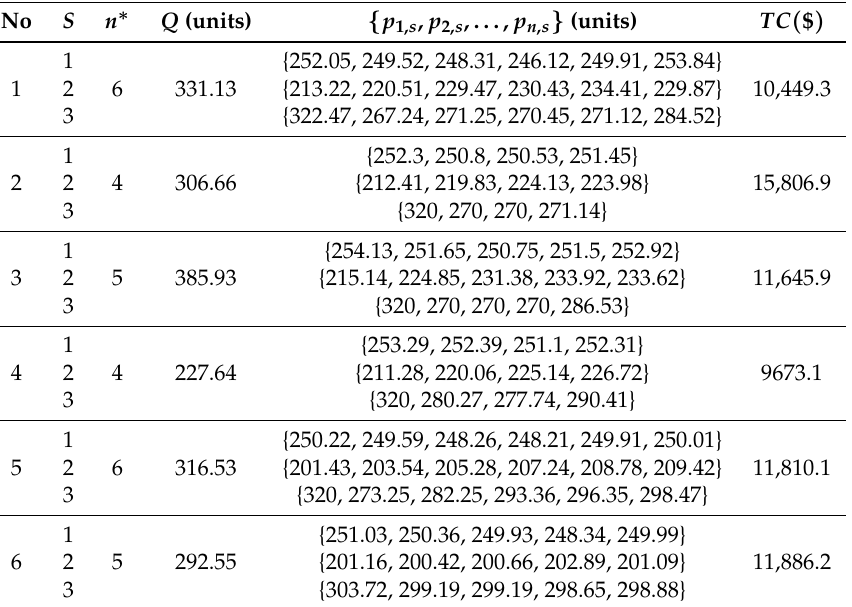
Table 4. Optimum result